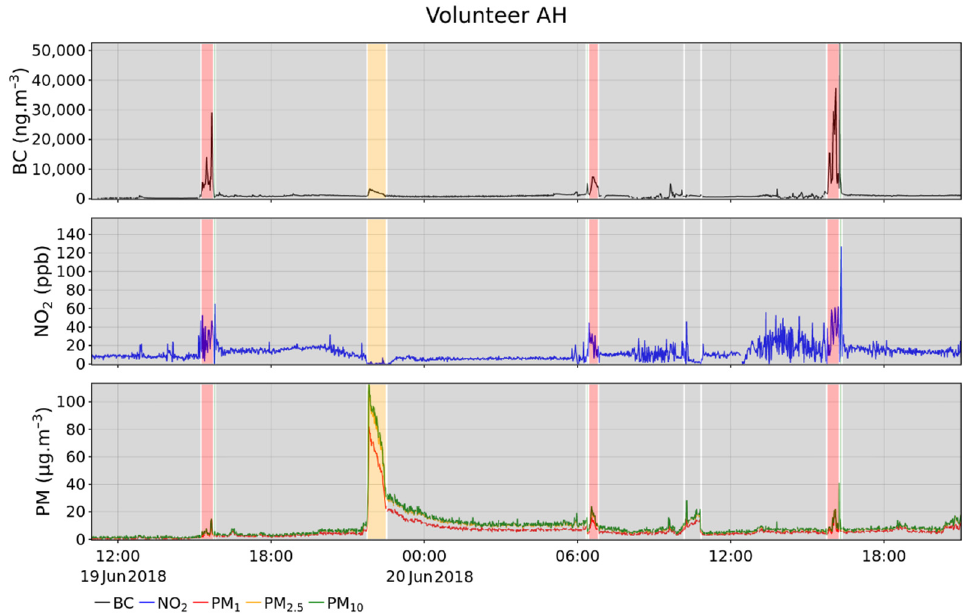
Figure 2. Exemplary time series of the measured PE to BC, NO 2 , and PM over four days (volunteer AH, spring